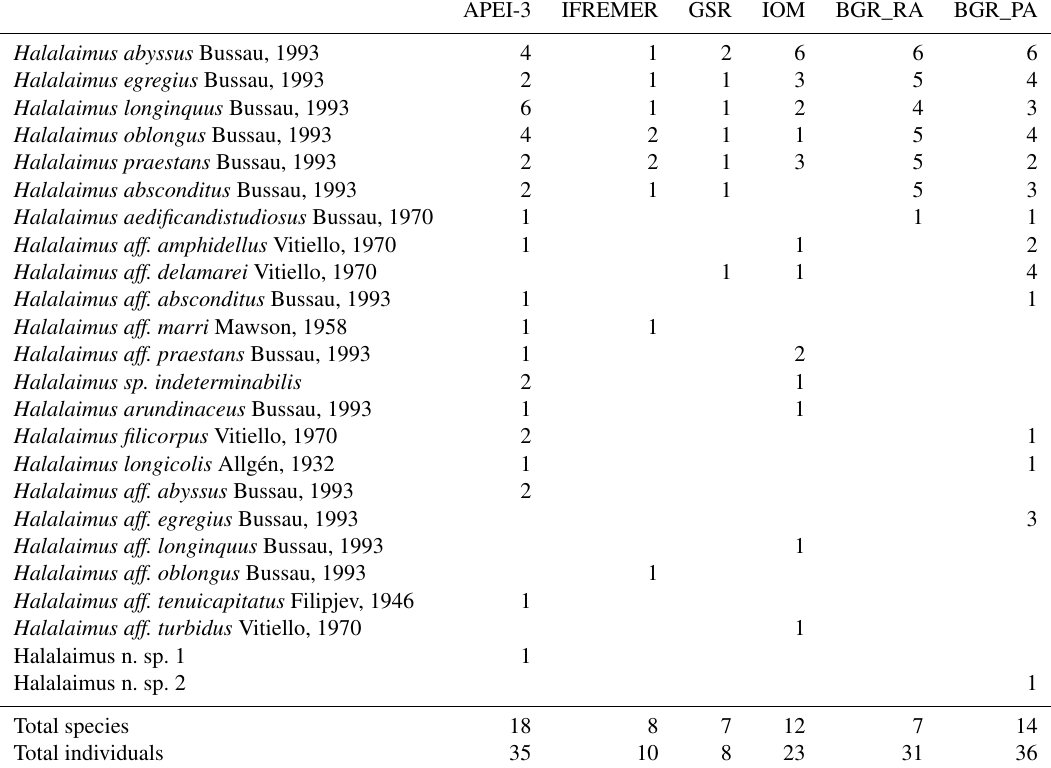
Table 7. Species counts for Halalaimus per area. Number of individuals per area for each species, ranked according to decreasing geograph- ical spread. When individuals strongly resembled a certain species but without a 100% match for all the characteristics, they were labelled as “affinity” (aff.) to the closest